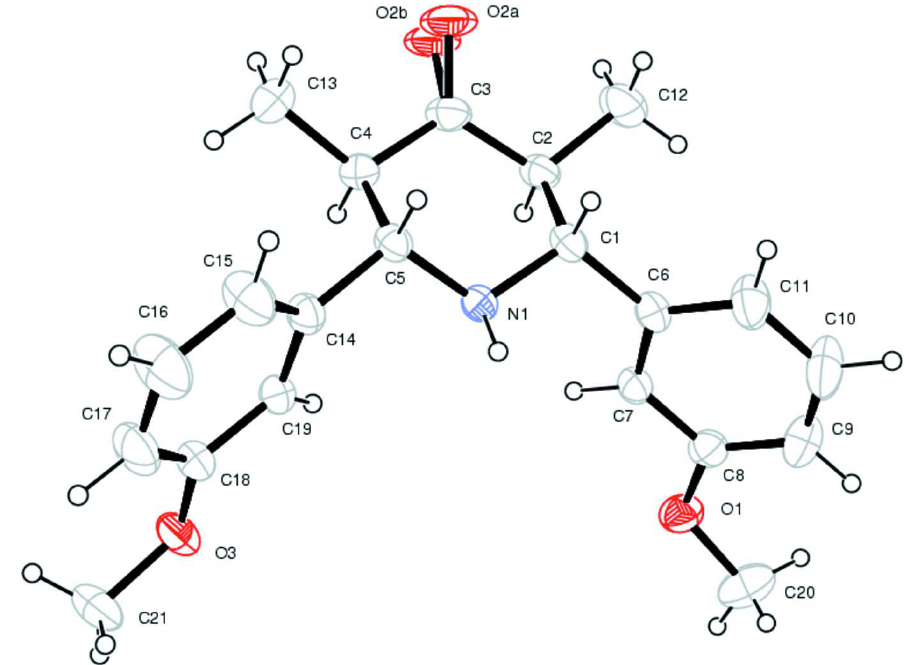
Figure 1 ORTEP of the molecule with atoms represented as 30% probability